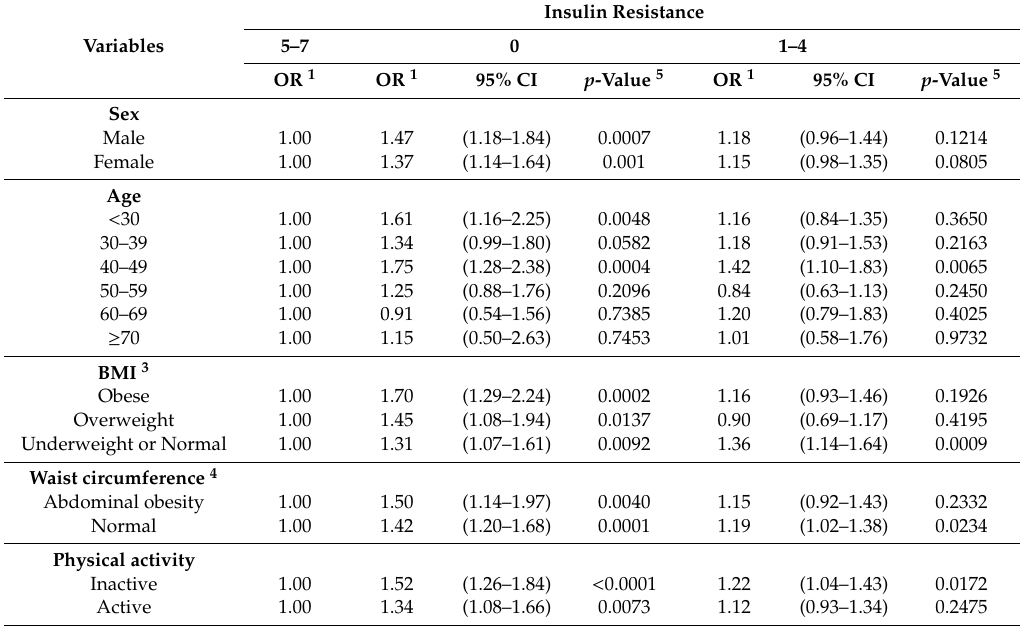
Table 3. Results of subgroup analysis for the association between weekly breakfast frequency and insulin resistance according to di ff erent